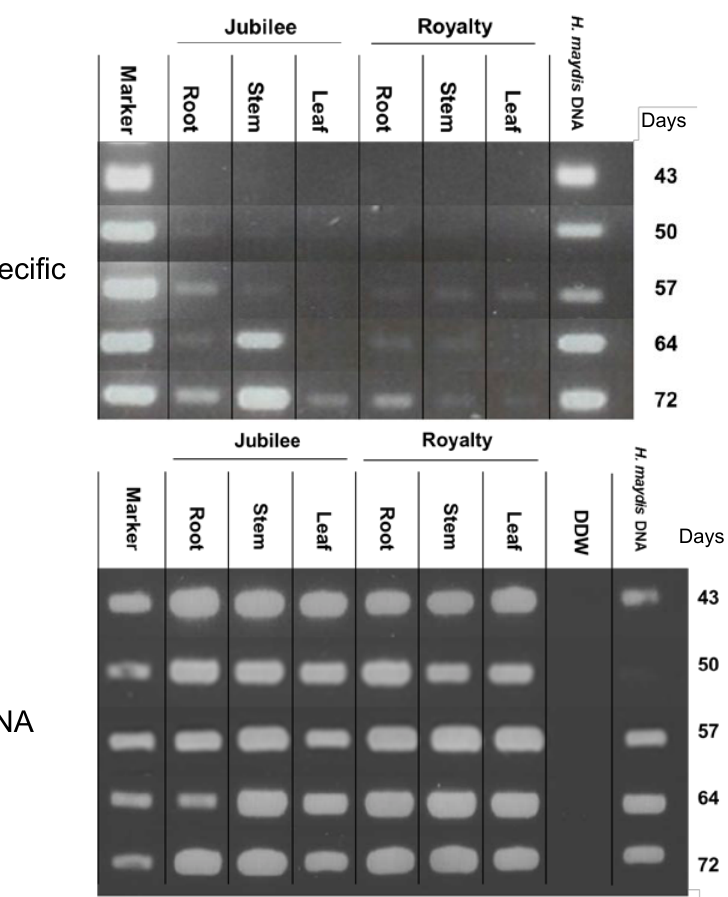
Figure 4. Molecular diagnosis of late wilt in maize plant samples (cv. Jubilee and Royalty) using PCR amplification of the unique Harpophora maydis oligonucleotide (upper panel) and rDNA (lower panel). Electrophoresis results show the pro - gression of the disease in roots, stems and leaves, from 43 d post-sowing until maturity. Marker - 200-bp DNA size marker (100 bp DNA ladder, NEB, Ornat, Rehovot, Israel); DDW - double-distilled water used as a template in the PCR mixture to ensure absence of DNA contamination; and H. maydis DNA - isolate Hm-3 , used as positive